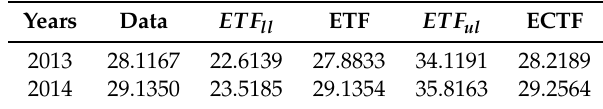
Table 3. Predictions from the trend functions of the proposed